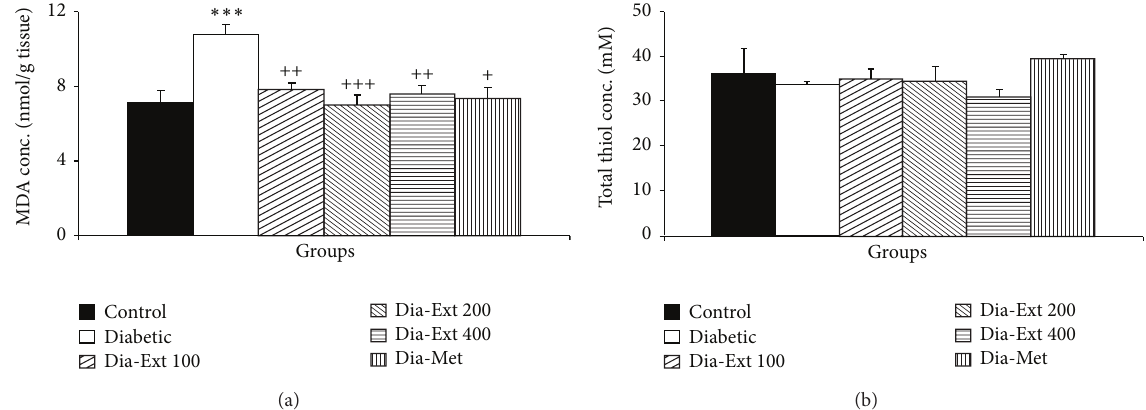
Figure 5: The MDA concentrations (a) and total thiol concentrations (b) in cortical tissues of 6 groups. Data are shown as mean ± SEM of 10 animals per group. ∗∗∗ 𝑃 < 0.001 in comparison with Control group and ++ 𝑃 < 0.01 and +++ 𝑃 < 0.001 in comparison with Diabetic